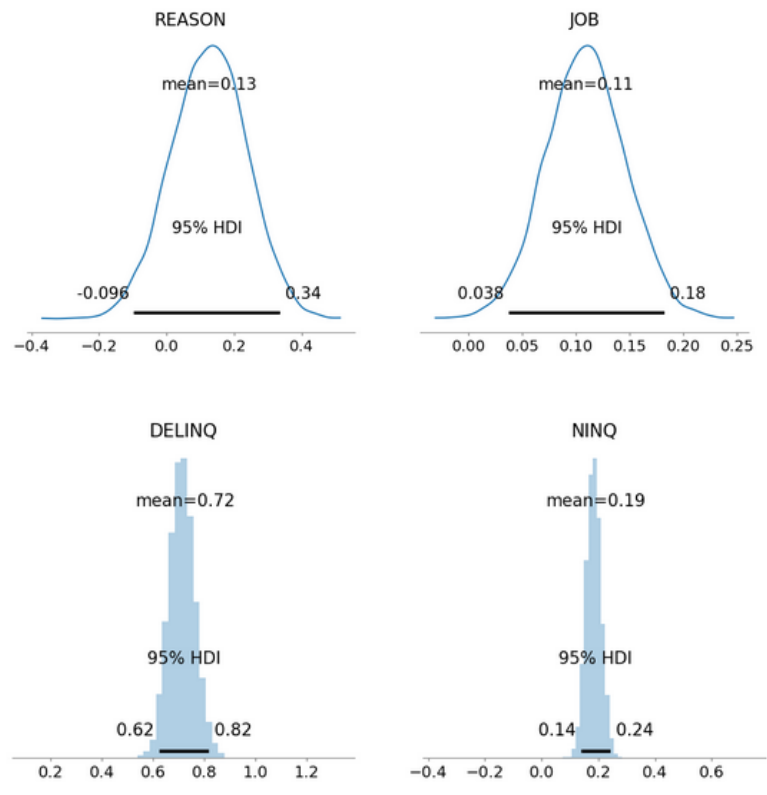
Figure 8. Visual inspection of sampling from the posterior by variable.